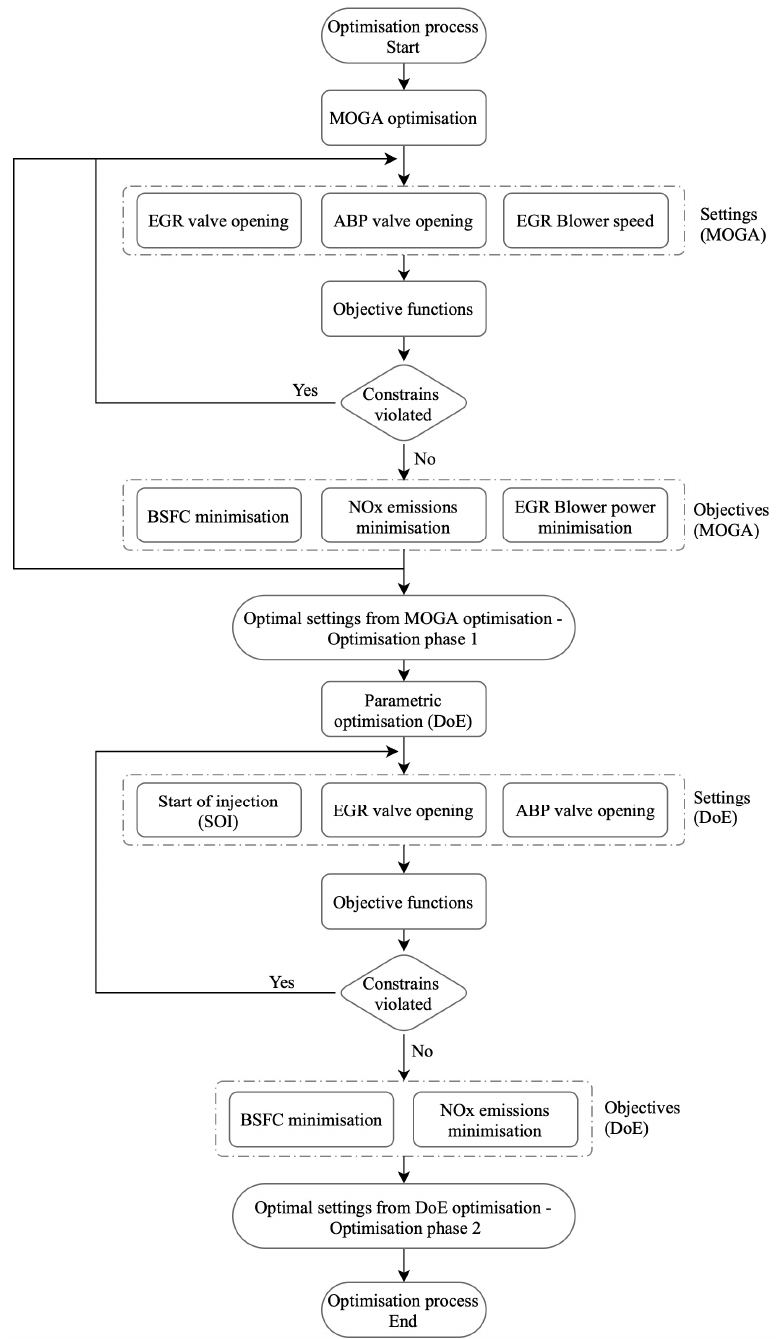
Figure 2. Optimisation process flowchart.